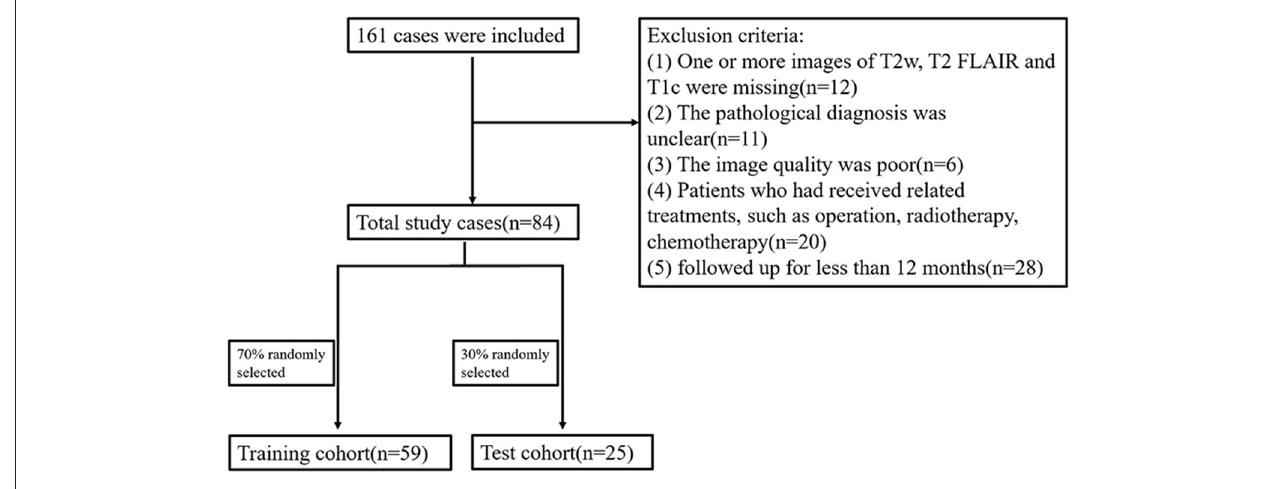
FIGURE 1 | Flowchart of patient inclusion and patient groupings.